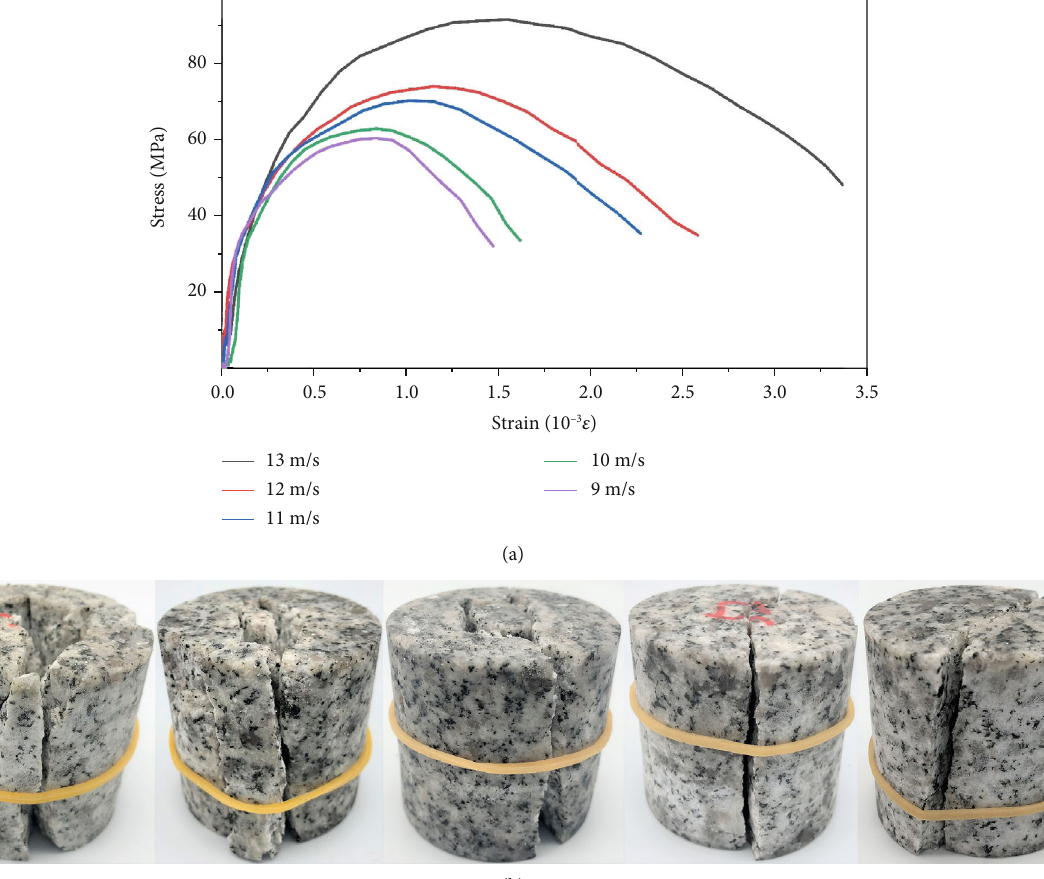
Figure 11: (a) Stress and strain change of granites under dynamic loading and (b) the failure types of granites with the impact velocity of 13m/s, 12m/s, 11m/s, 10m/s, and 9 m/s,